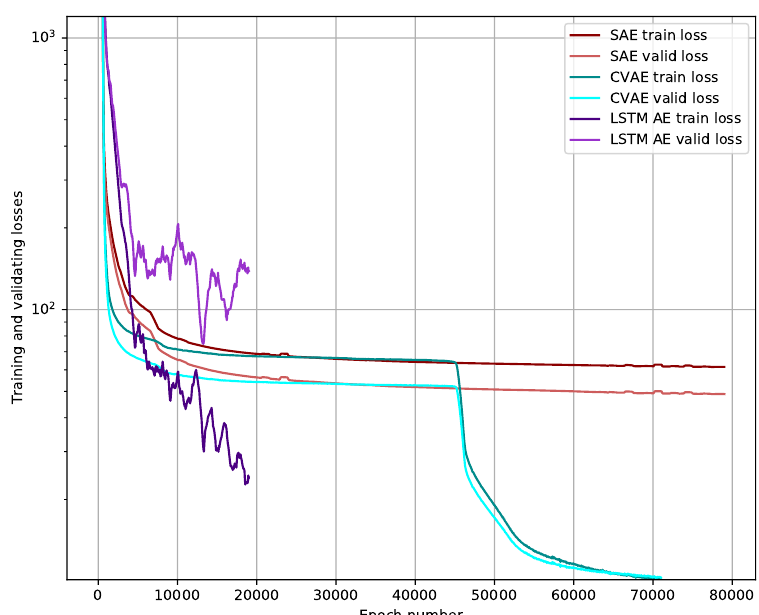
Figure 4. Training and validating losses are shown for the autoencoders being compared. All three equipped 10-dimensional latent space for comparability. The number of epochs is on the horizontal axis and the loss values are on logarhythmically scaled vertical